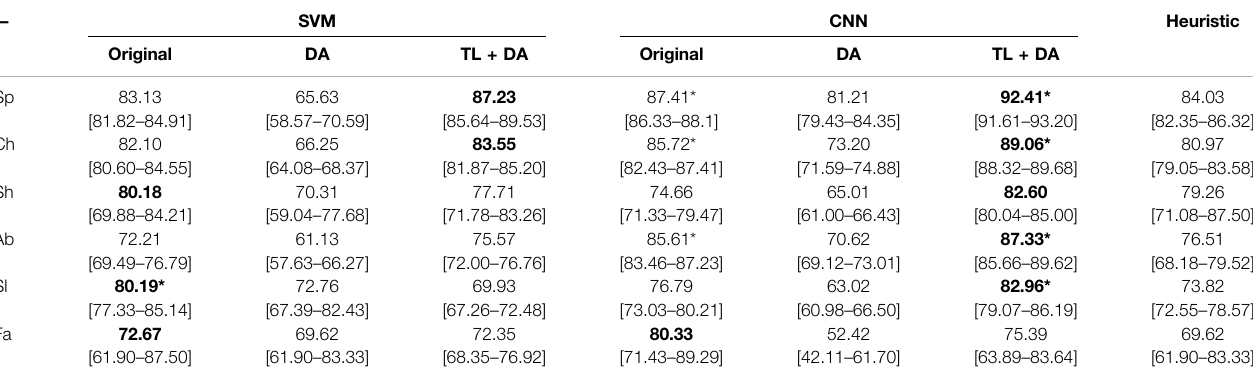
TABLE 3 | Performance ofthemachinelearningmodels for each ofthesub-groups oftheBS dataset. The results arepresented asmedian accuracy(25th percentile — 75th percentile) (%). On the left side, the results for the SVM. On the middle, the results for the CNN. On the right side, the results using the heuristic method in Charlton et al. (2021). The best results of each model that performed better than the heuristic approach for each breathing type are in